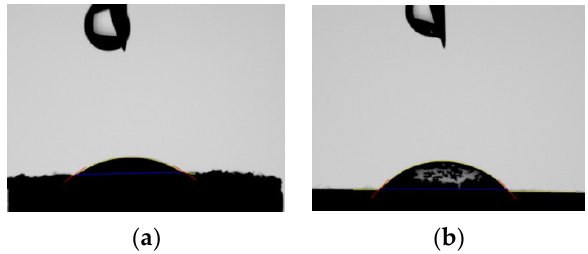
Figure 12. Contact angles of ( a ) aRB-PCL infiltrated and sintered in porous titanium substrate and ( b ) in porous titanium substrate.